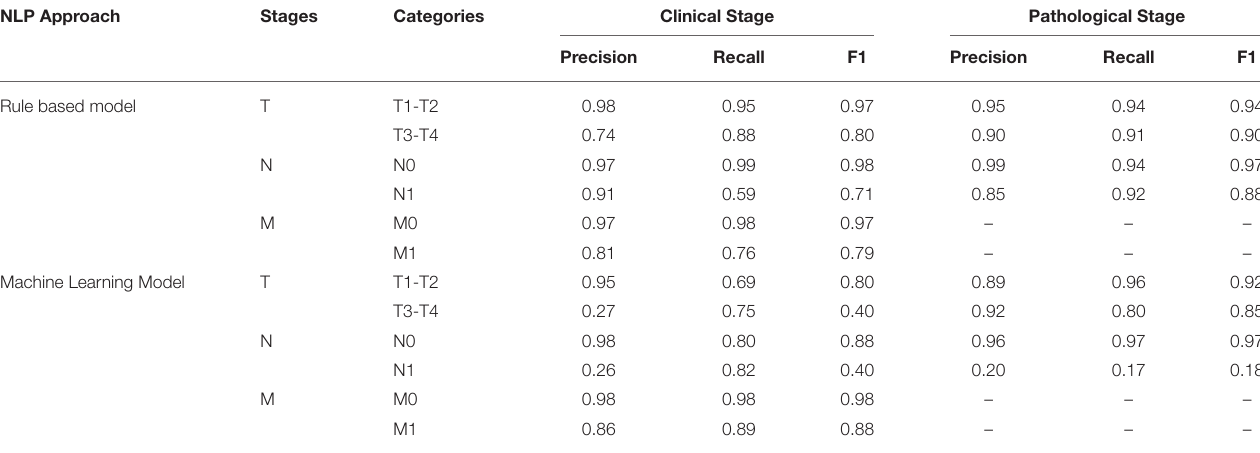
TABLE 2 | Evaluation of NLP models.